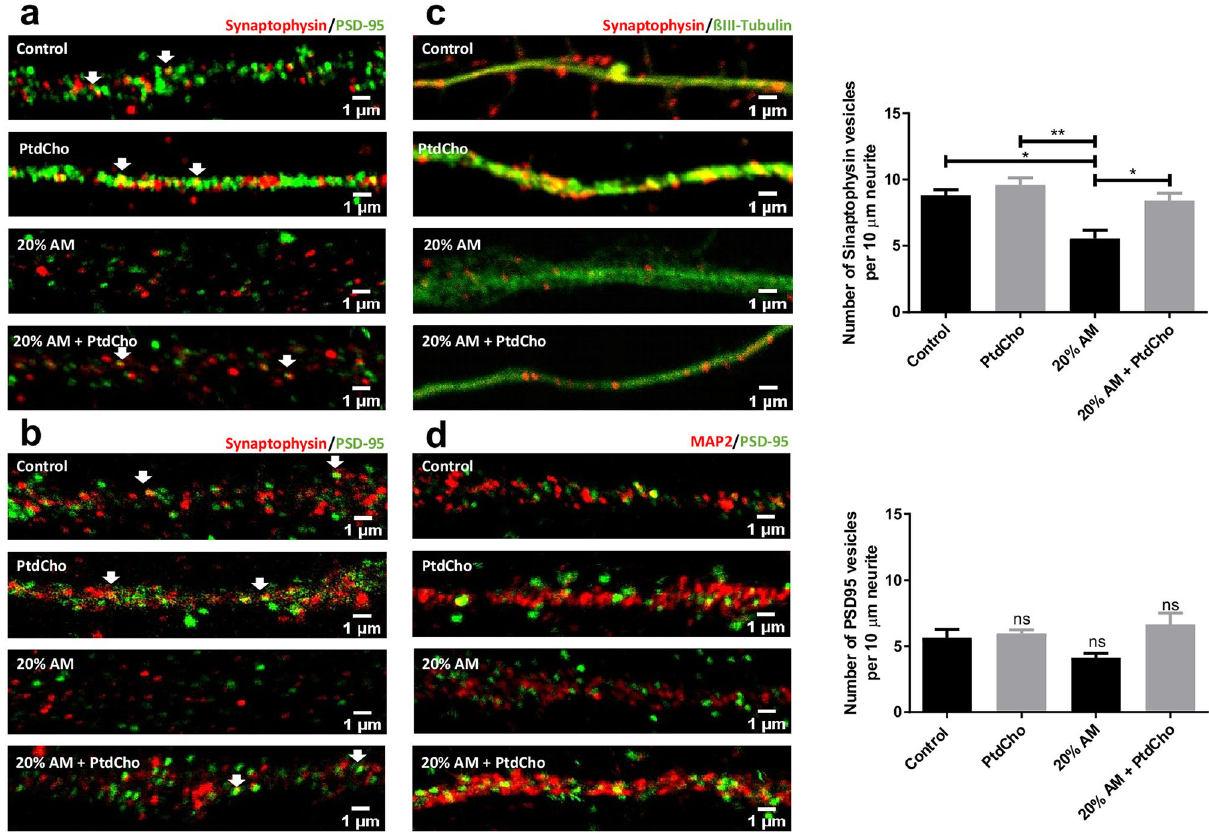
Figure 5. PtdCho supplementation restores synaptic defects caused by AM. Representative images (× 63) of the immunofluorescence assays with Synaptophysin (red) and PSD-95 (green) taken after 3 ( a ) and 7 ( b ) days of incubation in the indicated conditions. Scale bars: 1 μm. ( c ) Representative images (× 63) of the immunofluorescence assays with the neuronal marker (β-III tubulin, green) and synaptic vesicle marker (Synaptophysin, red). Scale bars: 1 μm. Quantification of Synaptophysin vesicles per 10 μm of neurite length. Graph represents the number of Synaptophysin-containing vesicles in 10 µm length measured in four independent experiments. Data were presented as mean ± SEM. **p < 0.01; *p < 0.05. ( d ) Representative images (× 63) of the immunofluorescence assays with the neuronal marker (MAP-2, green) and synaptic vesicle marker (PSD-95, red). Scale bars: 1 μm. Quantification of PSD-95 vesicles per 10 μm of length. Graph represents the number of PSD-95-containing vesicles in 10 µm length measured in four independent experiments. Data were presented as mean ± SEM. ns, no statistical